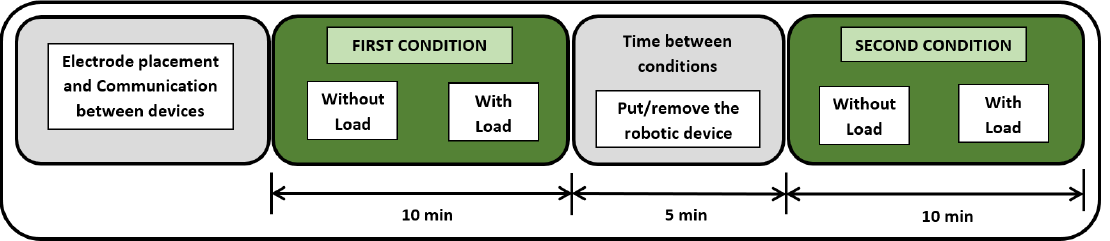
Figure 10. Study